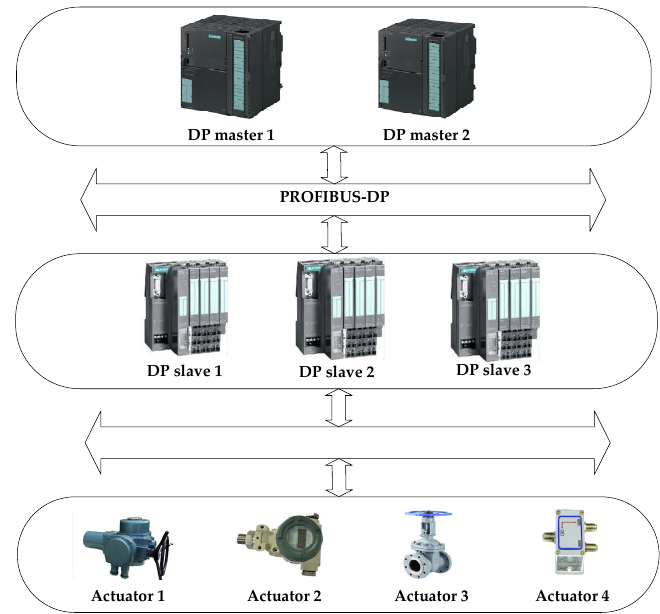
Figure 1. Typical PROFIBUS-DP systems.